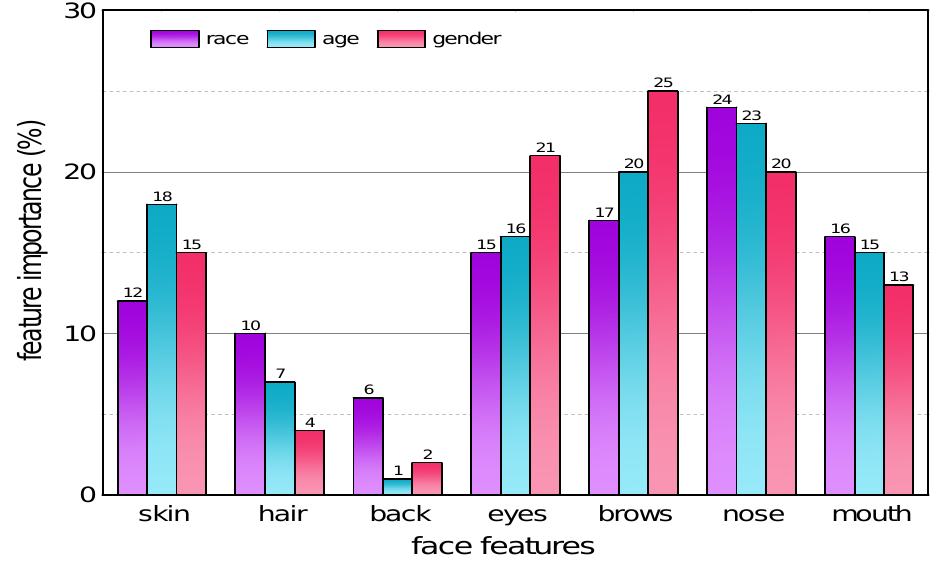
Figure 6. Feature importances of ‘skin’, ‘hair’, ‘back’, ‘mouth’, ’eyes’, ’brows’, and ‘nose’ for three facial attributes (race, age, and gender)